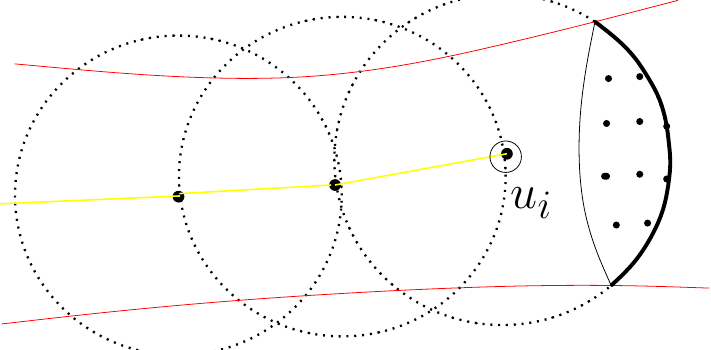
Figure 1. The AR u i maneuvers toward a frontierPt f ( u i ) . and the path of u i is plotted as yellow lines. Large dots on the path of u i plot the ARs, which are positioned along the path of u i . On the senseSphere of u i , frontierPts are plotted with